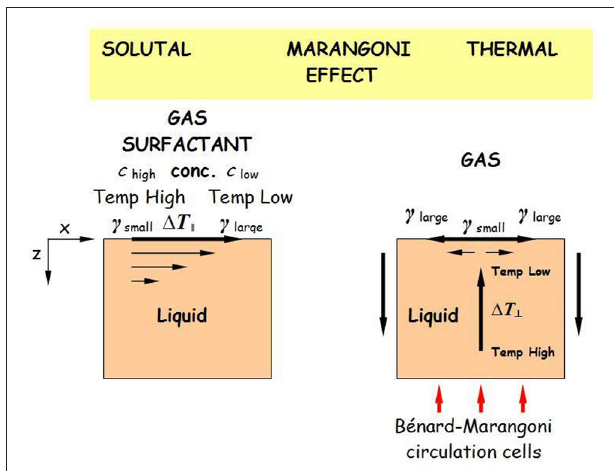
FIGURE 1 | Mechanism of surface tension-driven flow (modified after Hibiya and Ozawa,